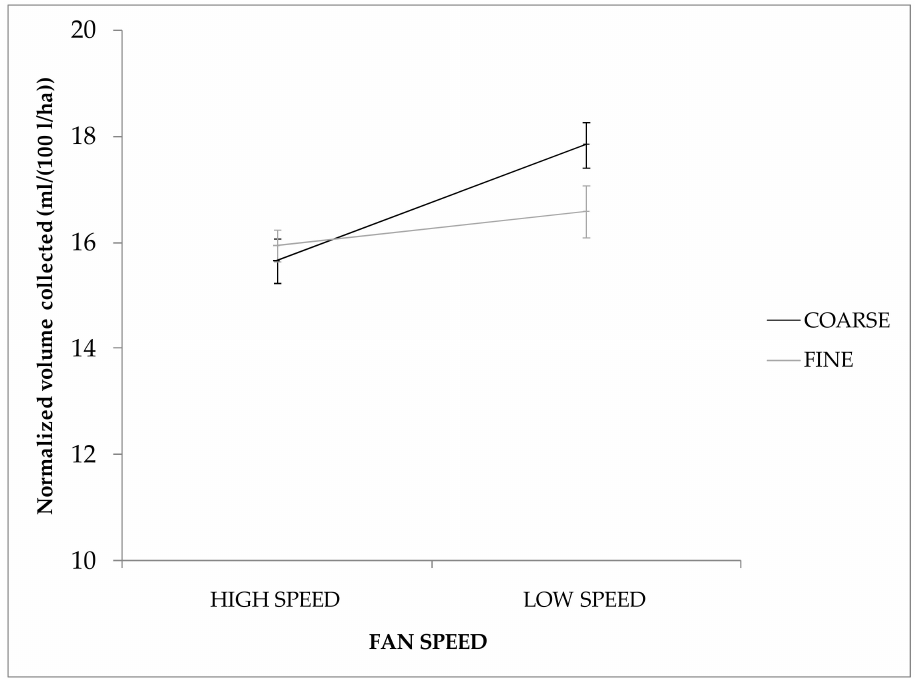
Figure 13. Nozzle type × Fan speed interaction effect on the normalized volume collected in the canopy zone (mean ± SE) with the T